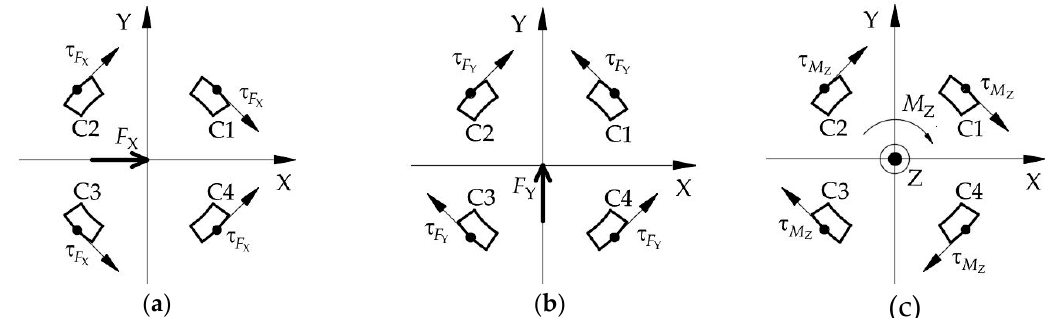
Figure 8. The shear stress’ direction of the points in the outside surface of layer C: ( a ) under the force F X ; ( b ) under the force F Y ; ( c ) under the torque M Z .